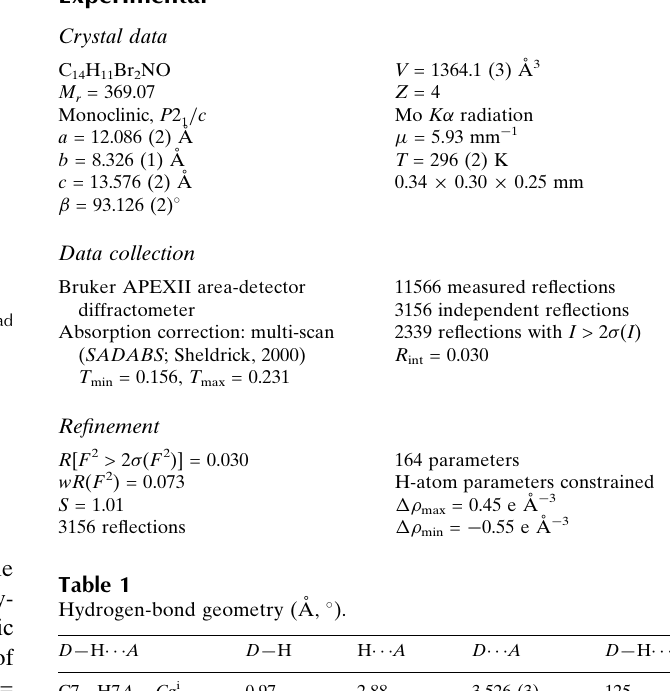
(cid:2) – (cid:2) stacking interactions between the phenol rings of neighbouring molecules = 3.530 (5) A˚ ]. In addition, the stacked molecules exhibit intermolecular C—H (cid:1) (cid:1) (cid:1) (cid:2) and intramolecular O—H (cid:1) (cid:1) (cid:1) N interactions.